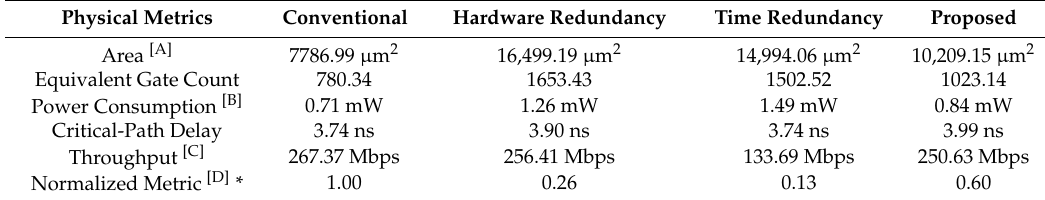
Table 2. Physical metrics for various LFSR designs with a length of 64.